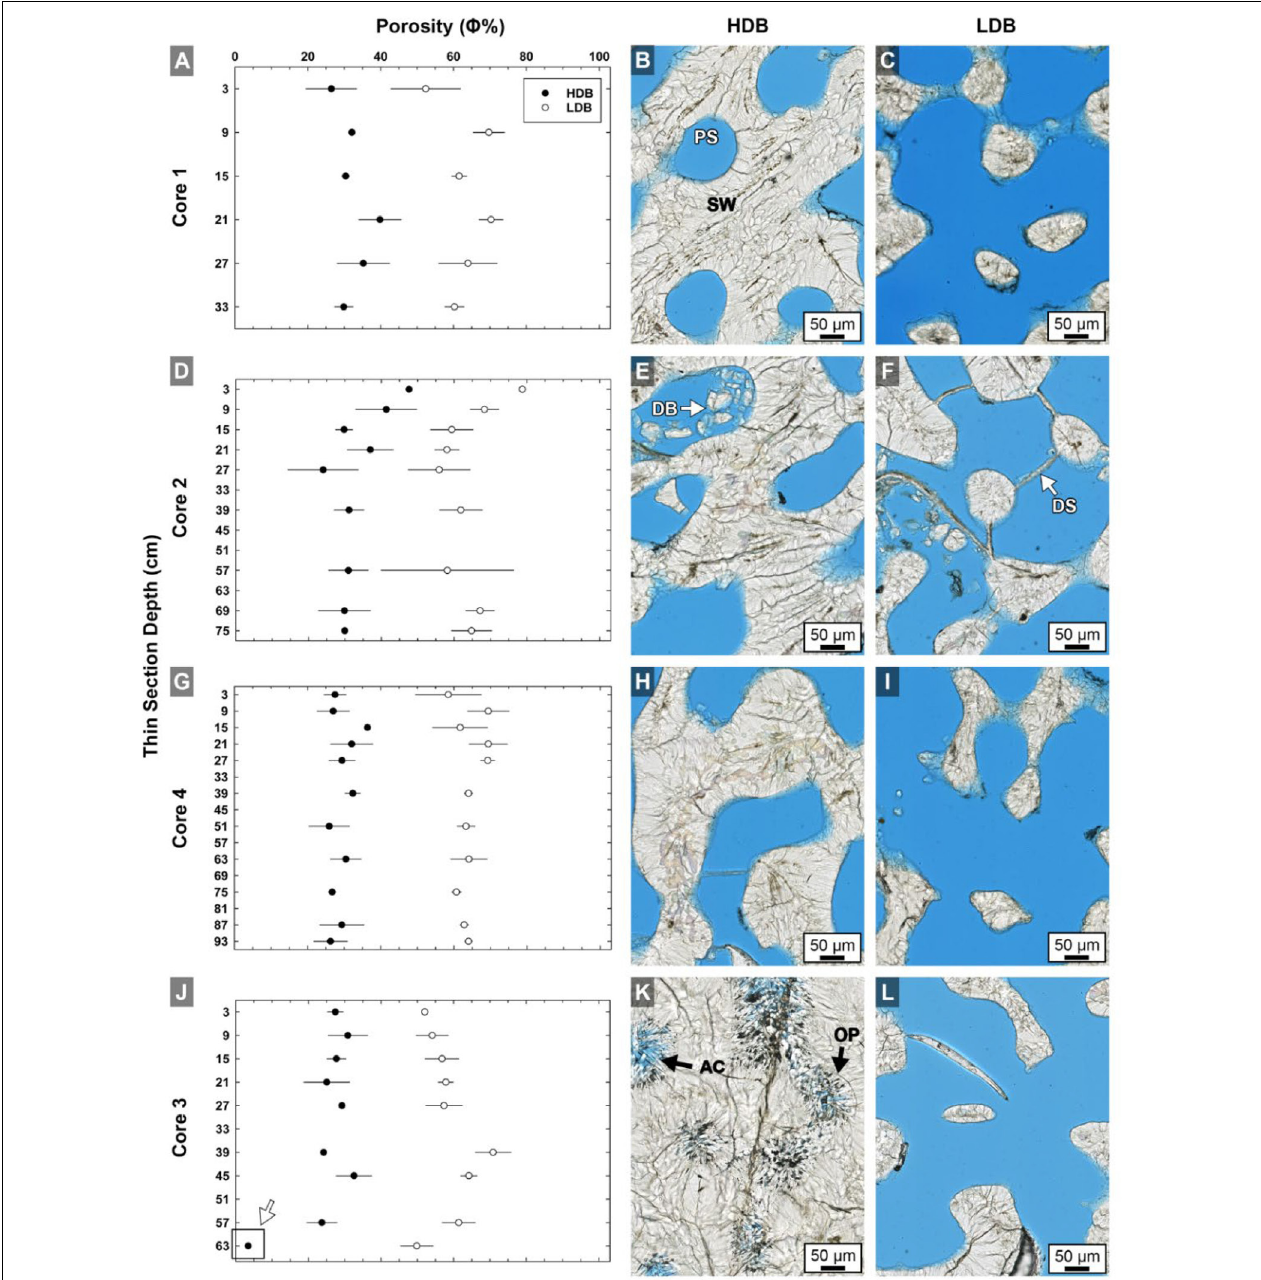
FIGURE 4 | Quantitative analyses of brightfield (BF) high-resolution images ( n = 420) of high-density band (HDB) and low-density band (LDB) percent porosity in Core 1 (A,B,C) , Core 2 (D,E,F) , Core 4 (G,H,I) , and Core 3 (J,K,L) as analyzed in thin sections from the present study ( Figure 1 ). Error bars represent standard deviations of measurements from multiple HDBs and LDBs from several images collected throughout each of the four cores. Analyses include cross-plots of average HDB and LDB porosity versus core depth, as well as example brightfield (BF) images from adjacent HDB and LDB couplet layers. The consistent 28–32% decrease in average HDB porosity is accentuated at the bottom of Core 3 (K,L) due to occlusion of porosity by diagenetic aragonite cements (white arrow in graph J ). Labeled coral skeleton and diagenetic components include: PS, pore space (blue epoxy); SW, skeletal wall; DB, debris; DS, dissepiments; AC, aragonite cement; and OP, original pore